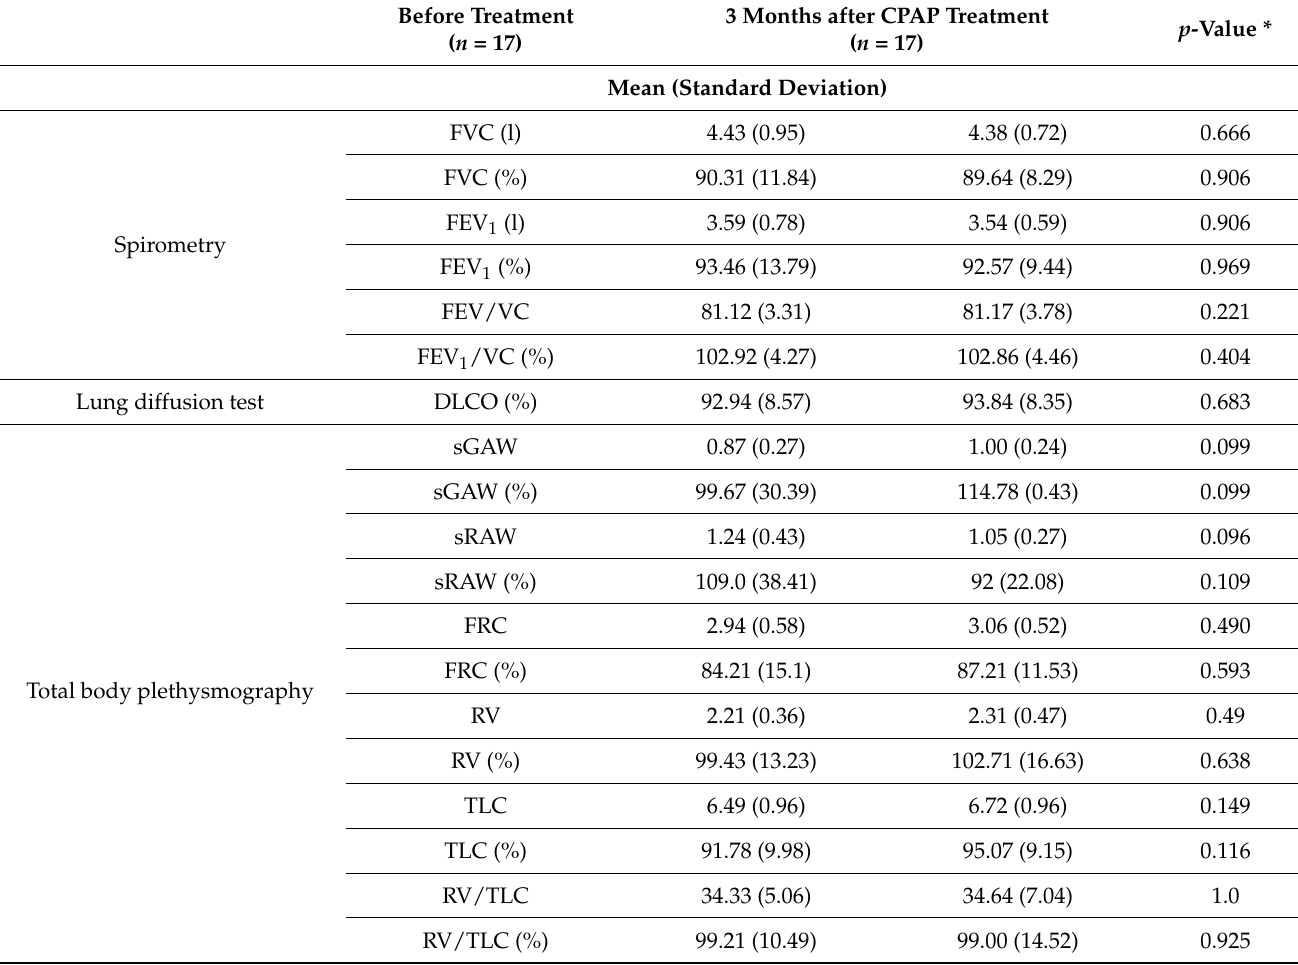
Table 3. Lung function test (spirometry, lung diffusion test, total body plethysmography)